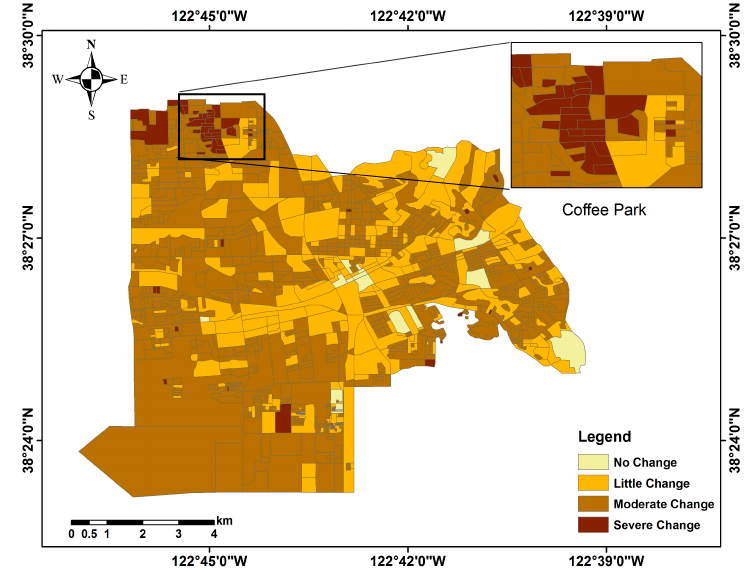
Figure 14. Santa Rosa standard deviation map indicating lower standard deviations on some street blocks in the north before the fire